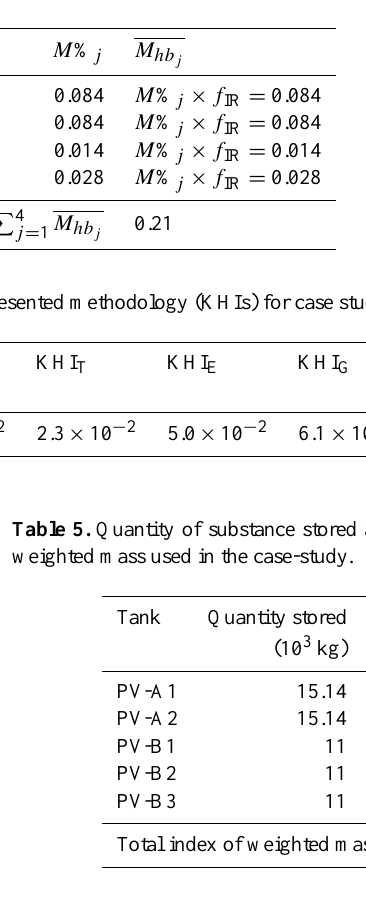
Table 2. Quantity of substance stored and corresponding index of weighted mass, used in the case-study.